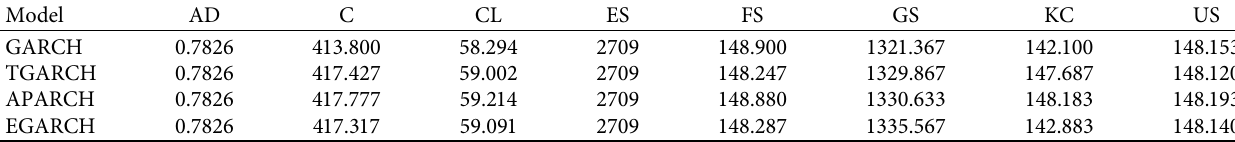
Table 11: Next month average predictions using GARCH